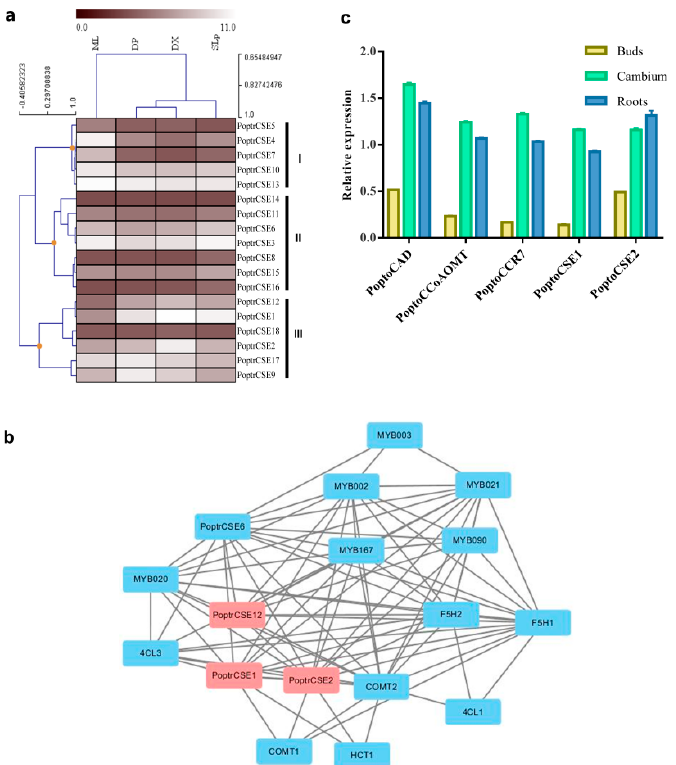
Figure 5. Expression profile and co-expression network of CSE and CSE -like genes in poplar. ( a ) Expression profile of PoptrCSE and PoptrCSE -like genes in various Populus tissues. Cluster analysis associated with the expression profile is also shown in this figure. Transcript levels are indicated by shading from dark red to white, as shown in the legend. Tissues or specific parts of plants are indicated with the respective abbreviations: DP, developing phloem; DX, developing xylem; ML, mature leaf; SLp, shoot and leaf primordium. The support information including the log2-transformed signal intensity and statistical test is available in Supplementary Table S6. ( b ) Co-expression network of PoptrCSE and PoptrCSE -like genes with identified genes involved in lignin biosynthesis. PoptrCSE1 , -2 and -12 are marked with red boxes. ( c ) Similar expression pattern of PoptoCSE1 and -2 , PoptoCAD , PoptoCCR7 and PoptoCCoAOMT using semi-qRT-PCR.